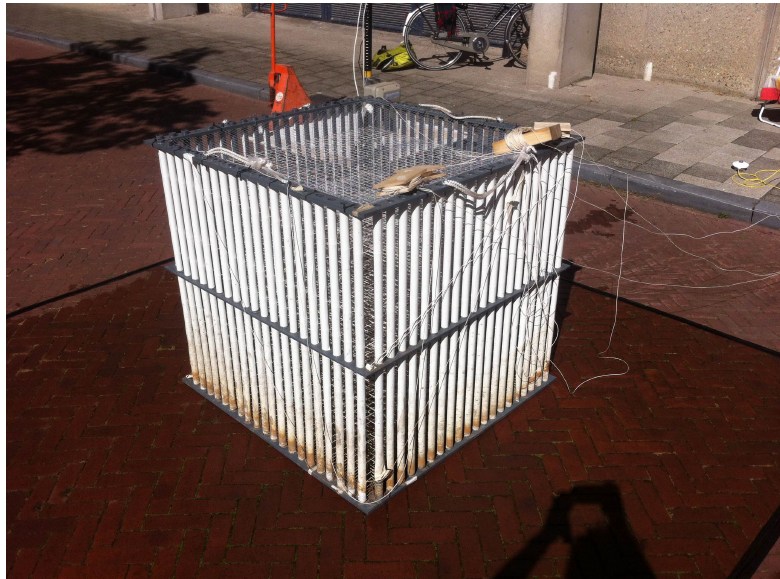
Figure 2. Measurement setup, consisting of the cage construction (1 m 3 ), for the